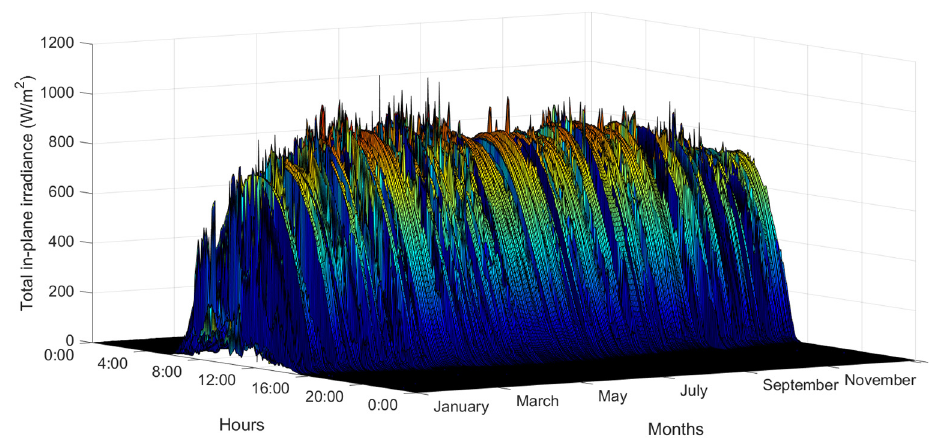
Figure 12. Daily irradiance profiles registered, every 5 min, from January to December 2011.